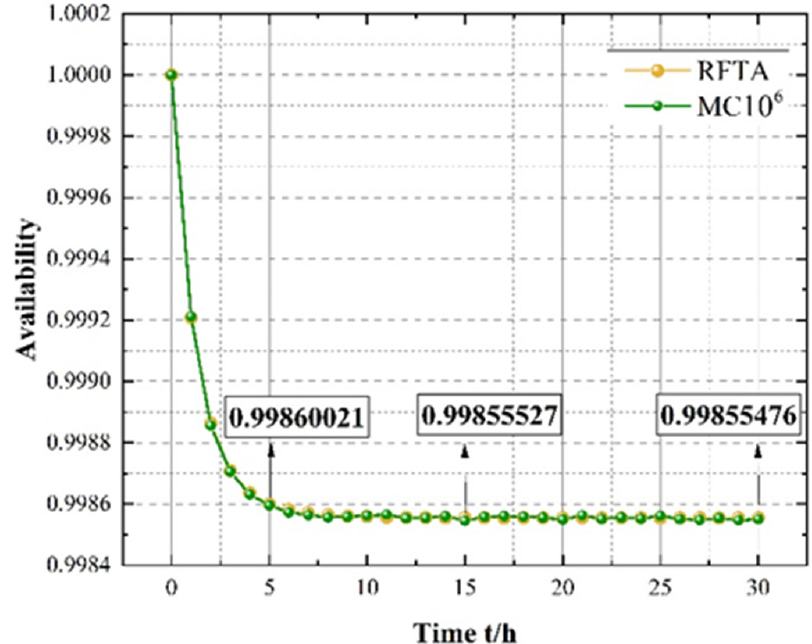
Figure 14. A comparison to the Monte Carlo algorithm.